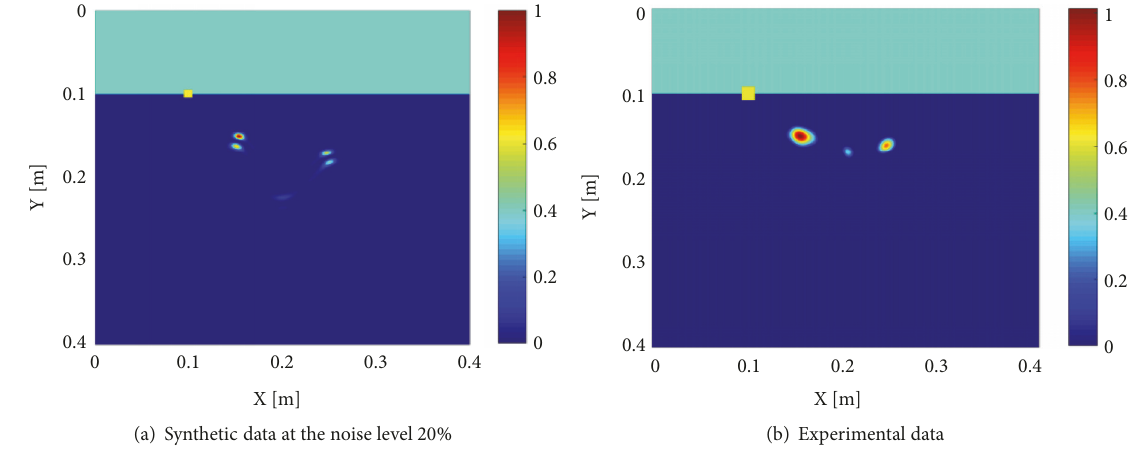
Figure 11: Comparison of the images formed by the Kirchhoff migration